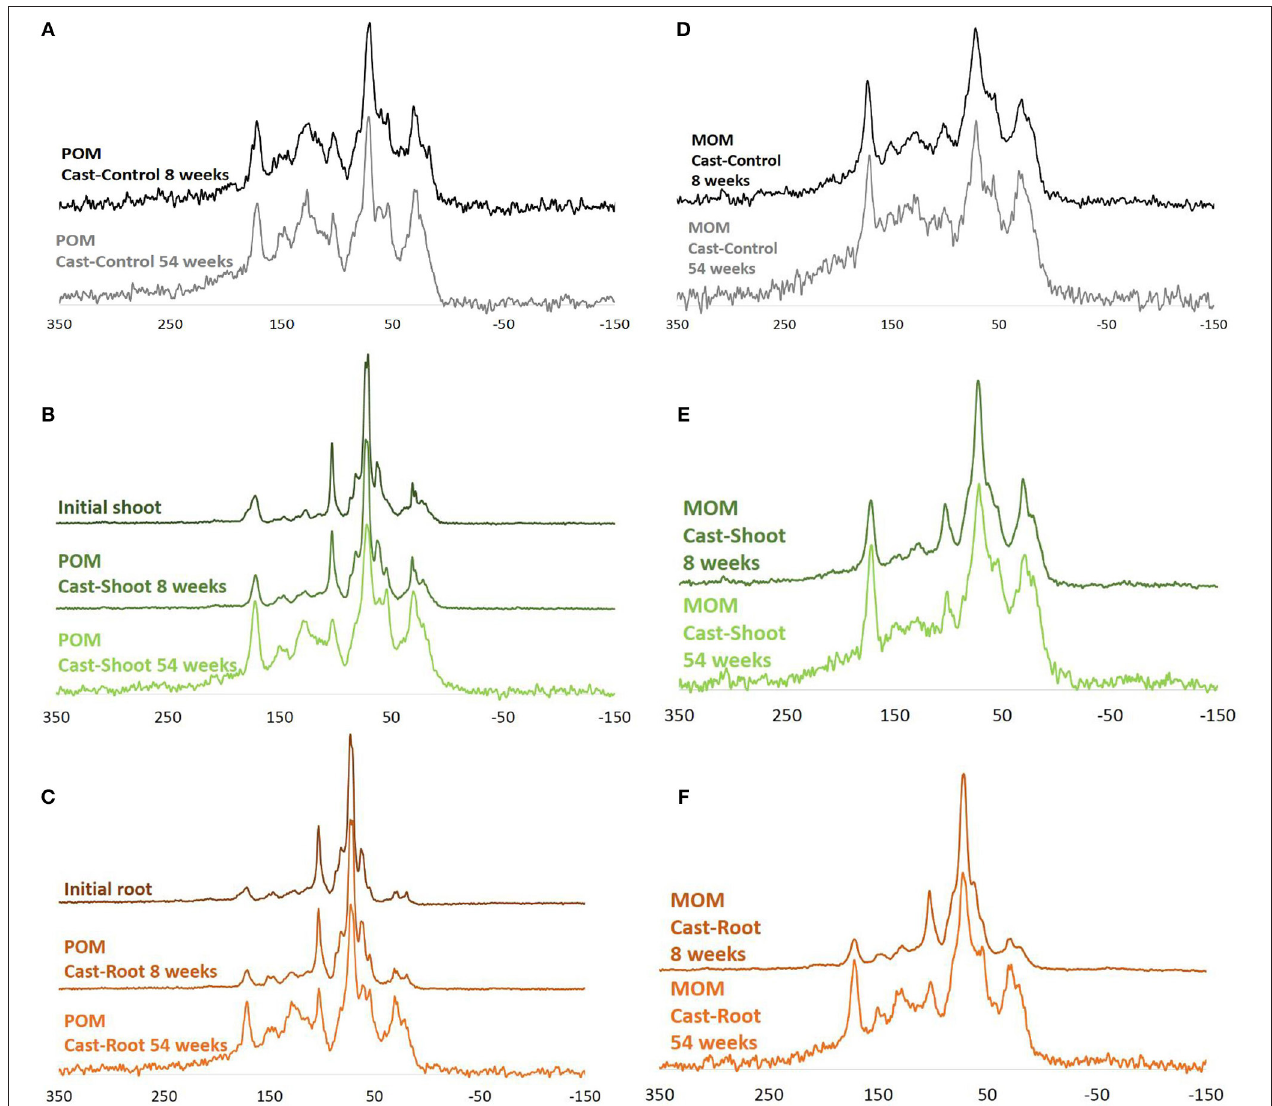
FIGURE 1 | 13 C Cross polarization magic angle nuclear magnetic resonance (NMR) spectra of POM and MOM fractions isolated from earthworm casts. Cast-Control ( A,D ), initial shoot and root spectra ( B,C , respectively), the POM fraction spectra for Cast-Shoot ( B ) and Cast-Root (C) after 8 and 54 weeks of experiment, as well as their corresponding MOM fraction spectra ( E , F , respectively).